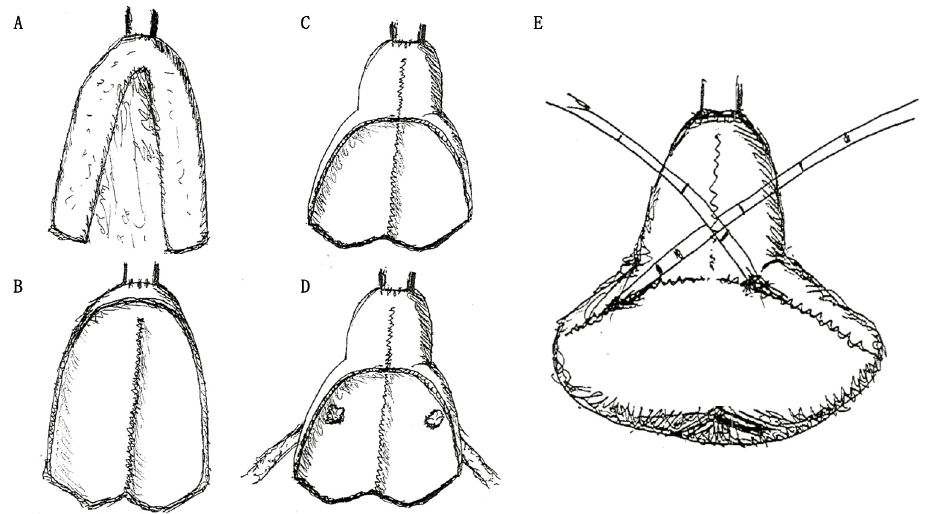
Figure 2. Shell neobladder reconstruction sketches. ( A ) Anastomosis between the urethra and the ileal tract identified for the future neobladder. ( B ) Configuration of the posterior plate. ( C ) Configuration of the neobladder neck. ( D ) Ureteral-neobladder anastomoses. ( E ) Configuration of the anterior plate.